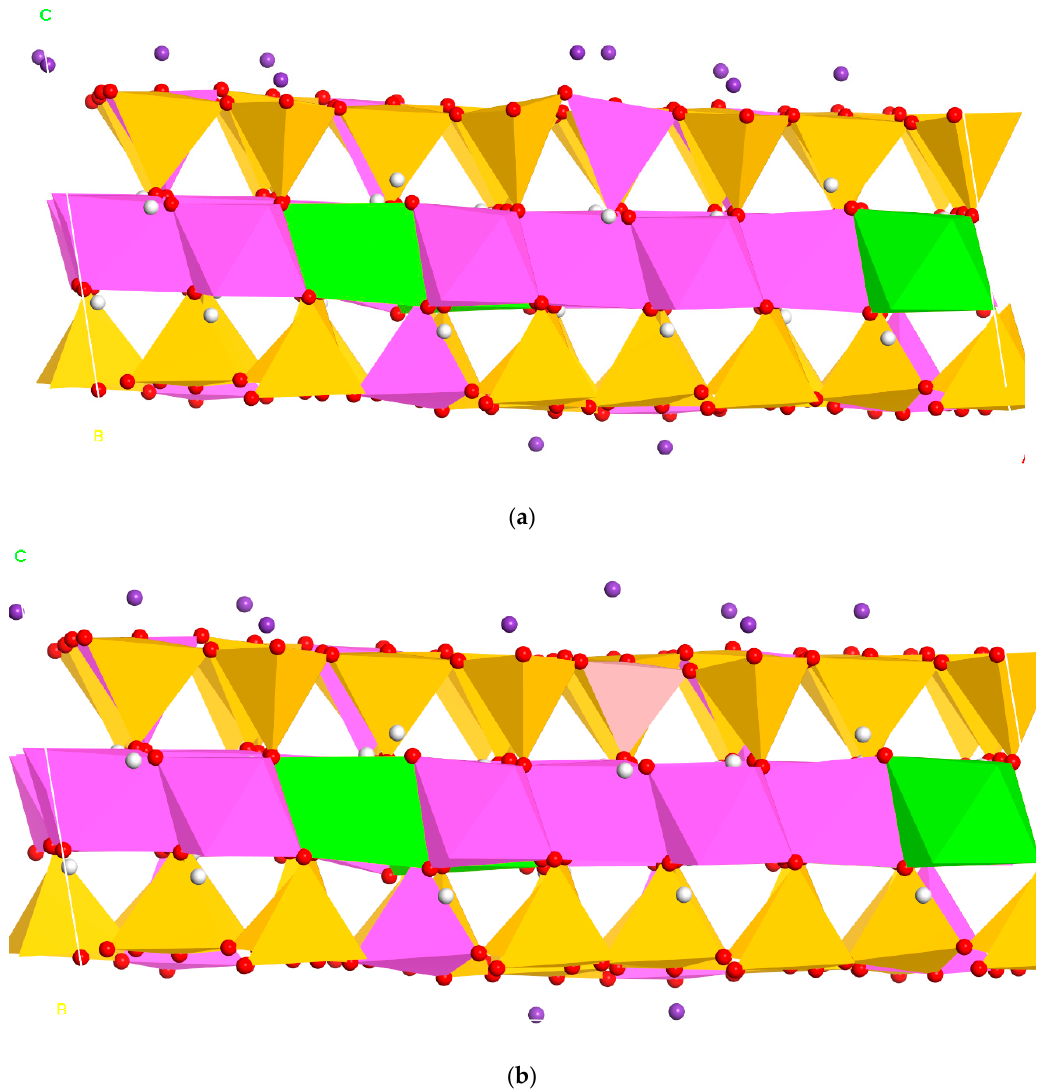
Figure 7. Optimized crystal structure of: the Al-illite model ( a ); and the B-illite model ( b ). The H, O and K atoms are represented in light-gray, red and fuchsia, respectively. The Si, Al, Mg and B polygons are in yellow, pink, green and orange, respectively.